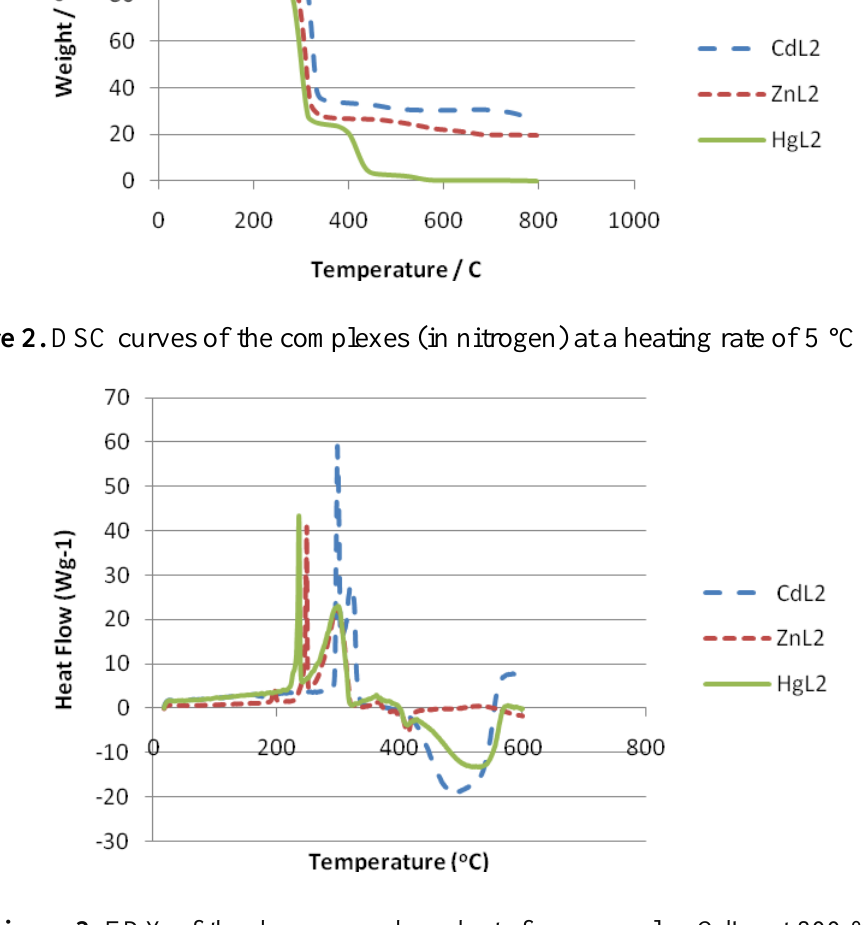
Figure 3. EDX of the decomposed products from complex CdL